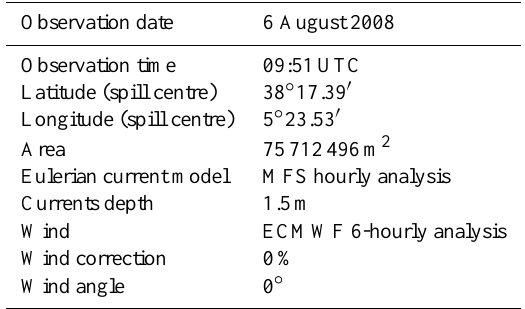
Table 4. Oil slick input data provided from satellite image analysis and wind/current fields